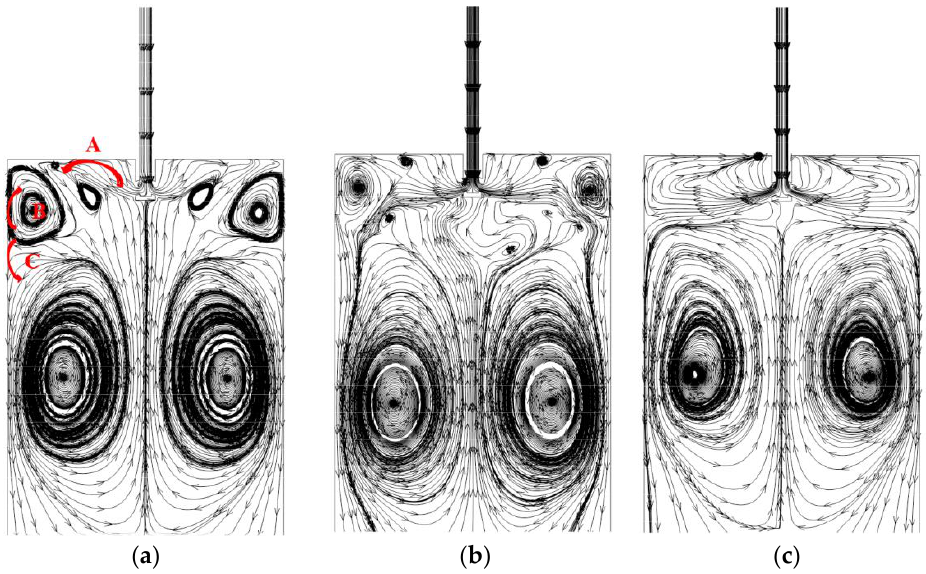
Figure 10. Streamlines on center plane of mold at different immersion depths of ( a ) 140 mm, ( b ) 160 mm, ( c ) 180 mm.